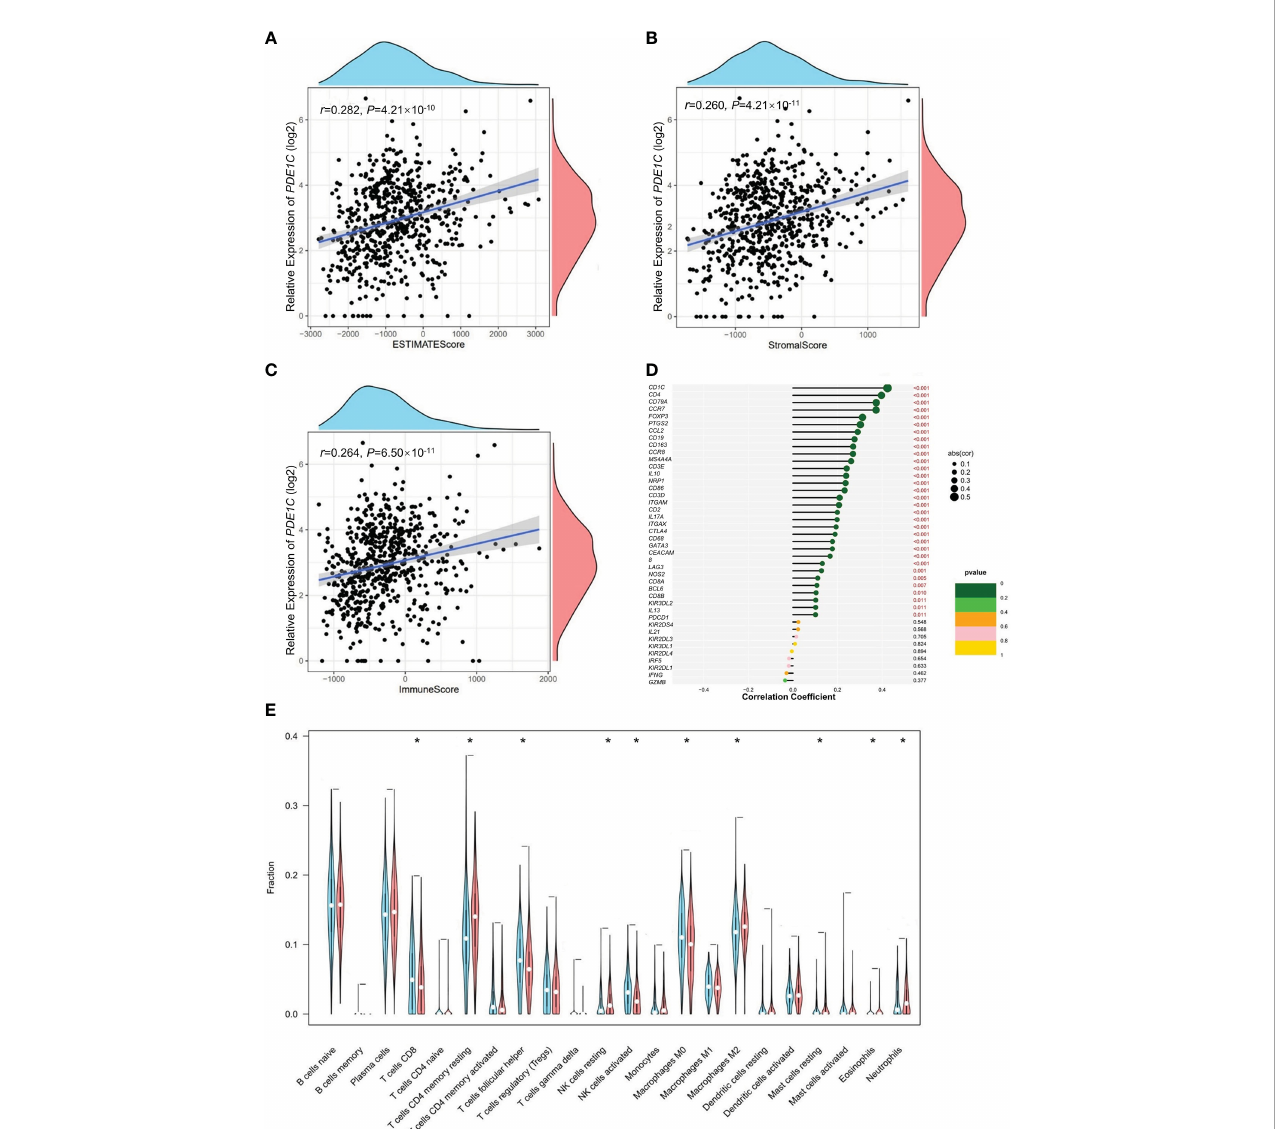
FIGURE 3 Immunity analysis of colorectal cancer. (A) Correlation analysis of PDE1C mRNA level expression level overall score of the tumor microenvironment. (B) Correlation analysis of PDE1C mRNA expression level and the tumor microenvironment stromal cell score. (C) Correlation analysis of PDE1C mRNA expression level and immune cell score in the tumor microenvironment. (D) Correlation analysis between PDE1C mRNA expression level and immune cell maker genes in the TCGA. (E) PDE1C high and low mRNA expression level group variance analysis with 22 immunity cells. * P <